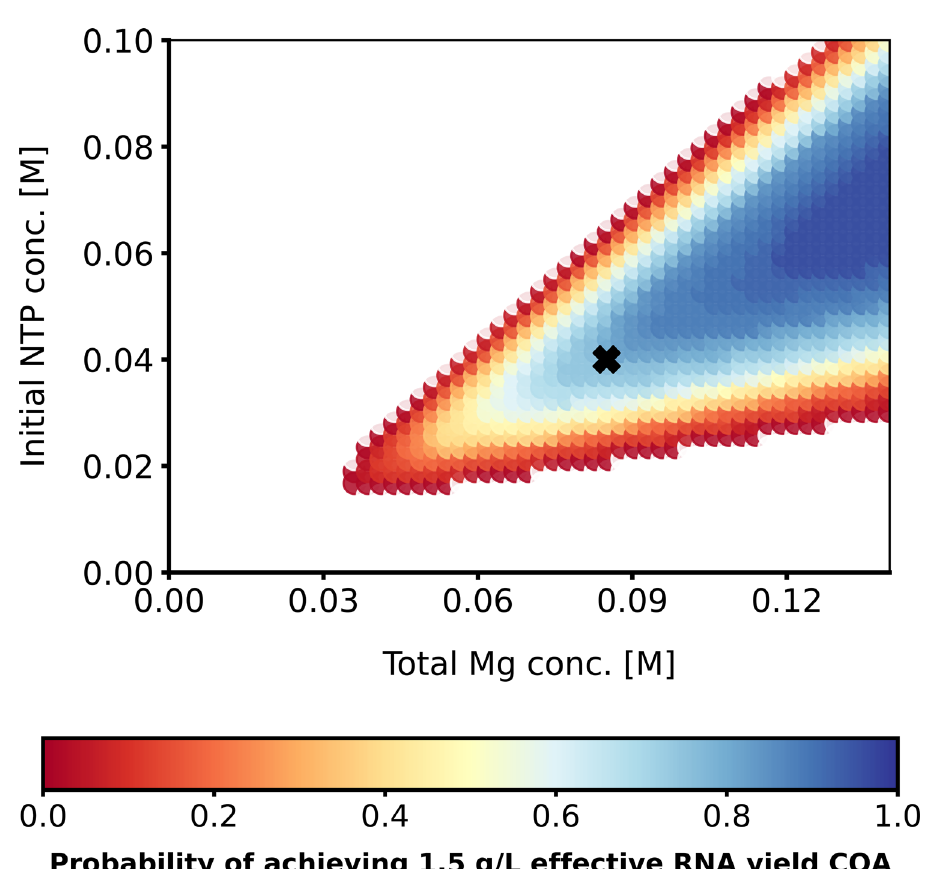
Fig. 4 Two-dimensional probabilistic design space. The probability of achieving the 1.5 g/L RNA effective yield CQA under 20% standard deviation in the kinetic rate constant model parameters at a fi xed 10 − 8 M T7RNAP concentration. The probability is illustrated by the colour code. The black cross represents the cost-optimal point.